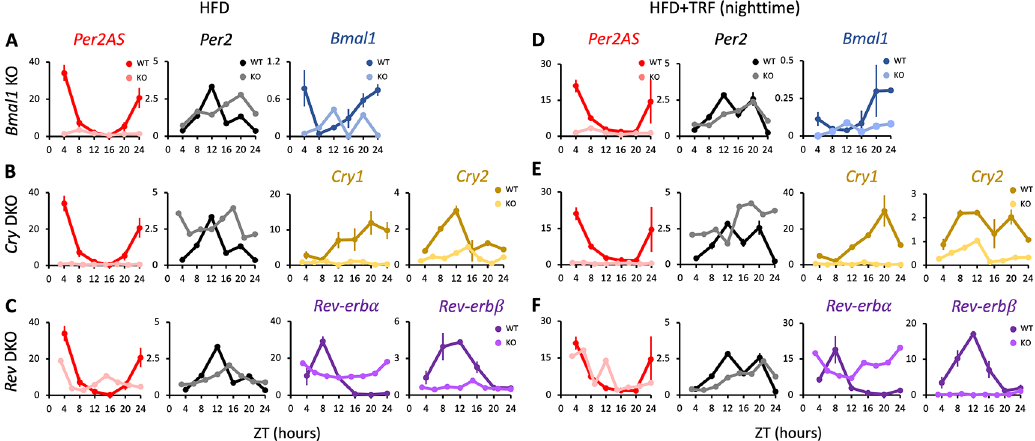
Figure4.Theexpressionpatternsof Per2AS and Per2 withhigh-fatdiet(HFD). MicewerekeptunderanL:D=12:12 cycle and fed with a 60% high-fat diet either ad lib (A-C) or with TRF (D-F) condition. Liver RNAs were extracted every four hours inwild type and(A) Bmal1 knockout mice,oreverythree hours in(B) Cry1/2 doubleand(C) Nr1d1/2 double knockout mice. Y-axis represents strand-specific TPM. The same WT mice were used in each group. Points and error bars represent mean (cid:2) SE (n=2). Two-way ANOVA analysis was not performed for this dataset, because the KO samples consisted of a single biological replicate. Data derived from Chaix et al ., Cell Metab. , 2019.